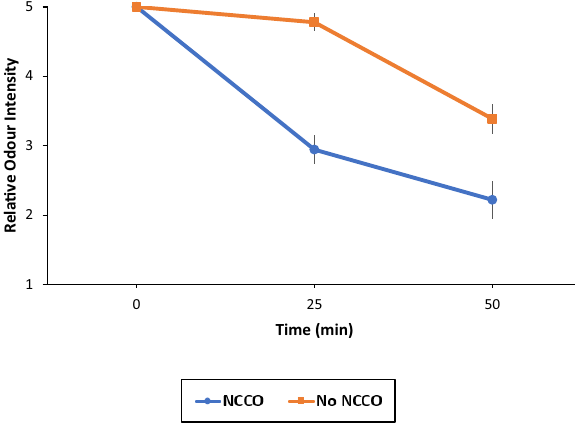
Fig. 7 Summary of average relative odour intensity through treat- ment time. Error bar represents 1